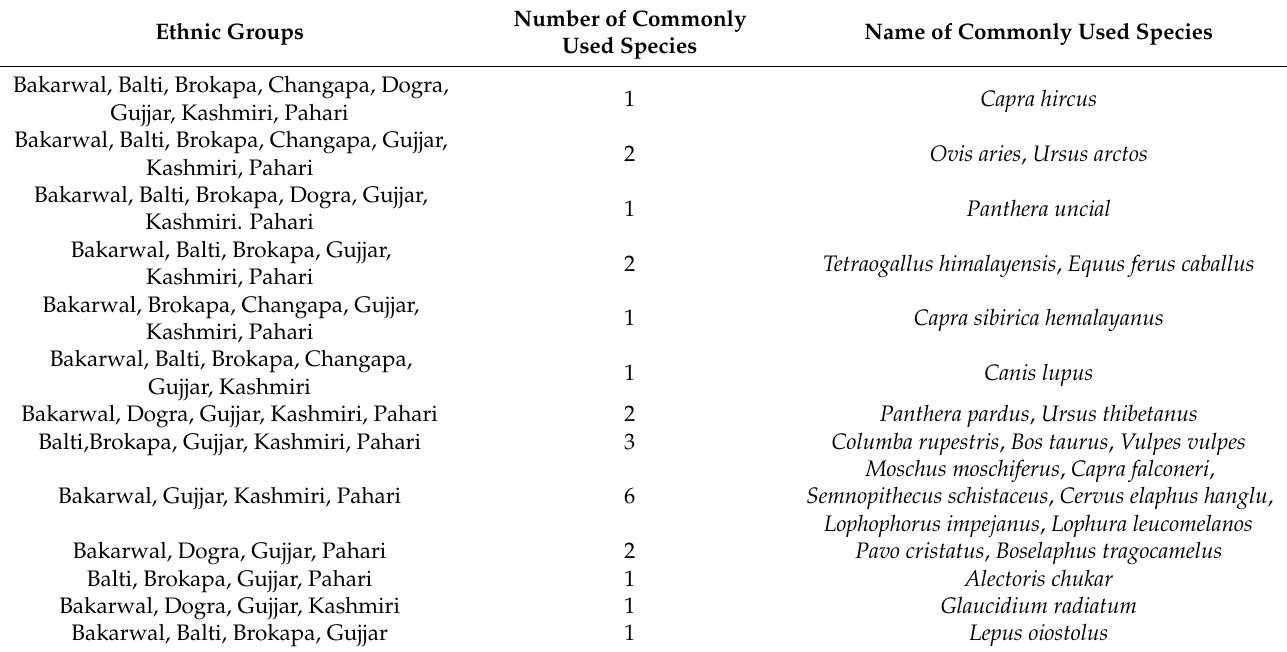
Table 3. Overlap of species usage across the selected ethnic groups. Ethnic